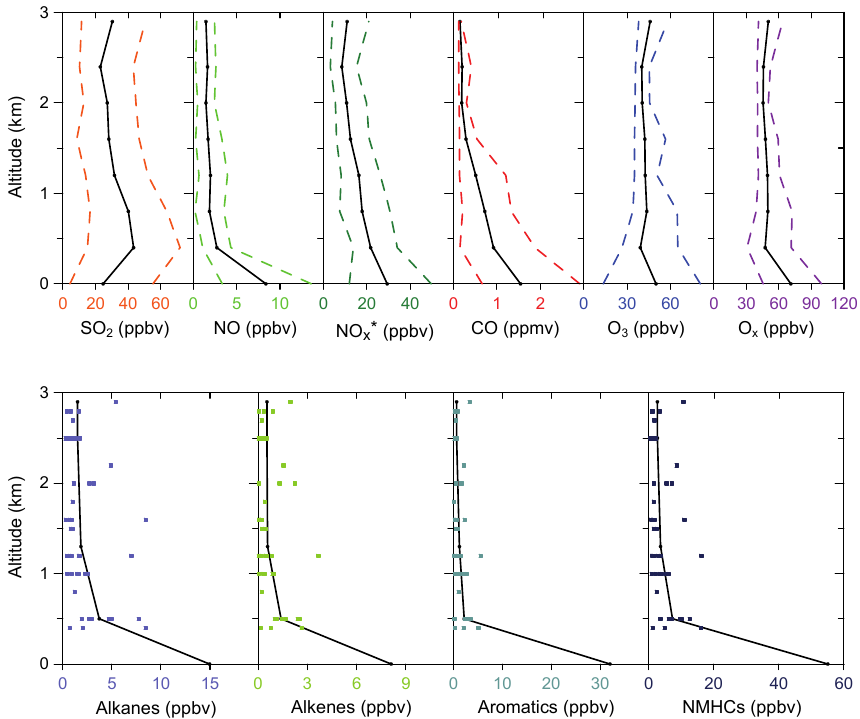
Fig. 10. Vertical profiles of gaseous pollutants measured by aircraft combined with daytime surface measurements at the Xin’an station. Black solid lines are mean values, colored dashed lines are 10th and 90th percentiles of the data for inorganic gases, and colored dots are values for each VOC sample. O x is O 3 plus NO 2 , the latter derived by scaling measured NO with the NO 2 /NO ratios simulated with our